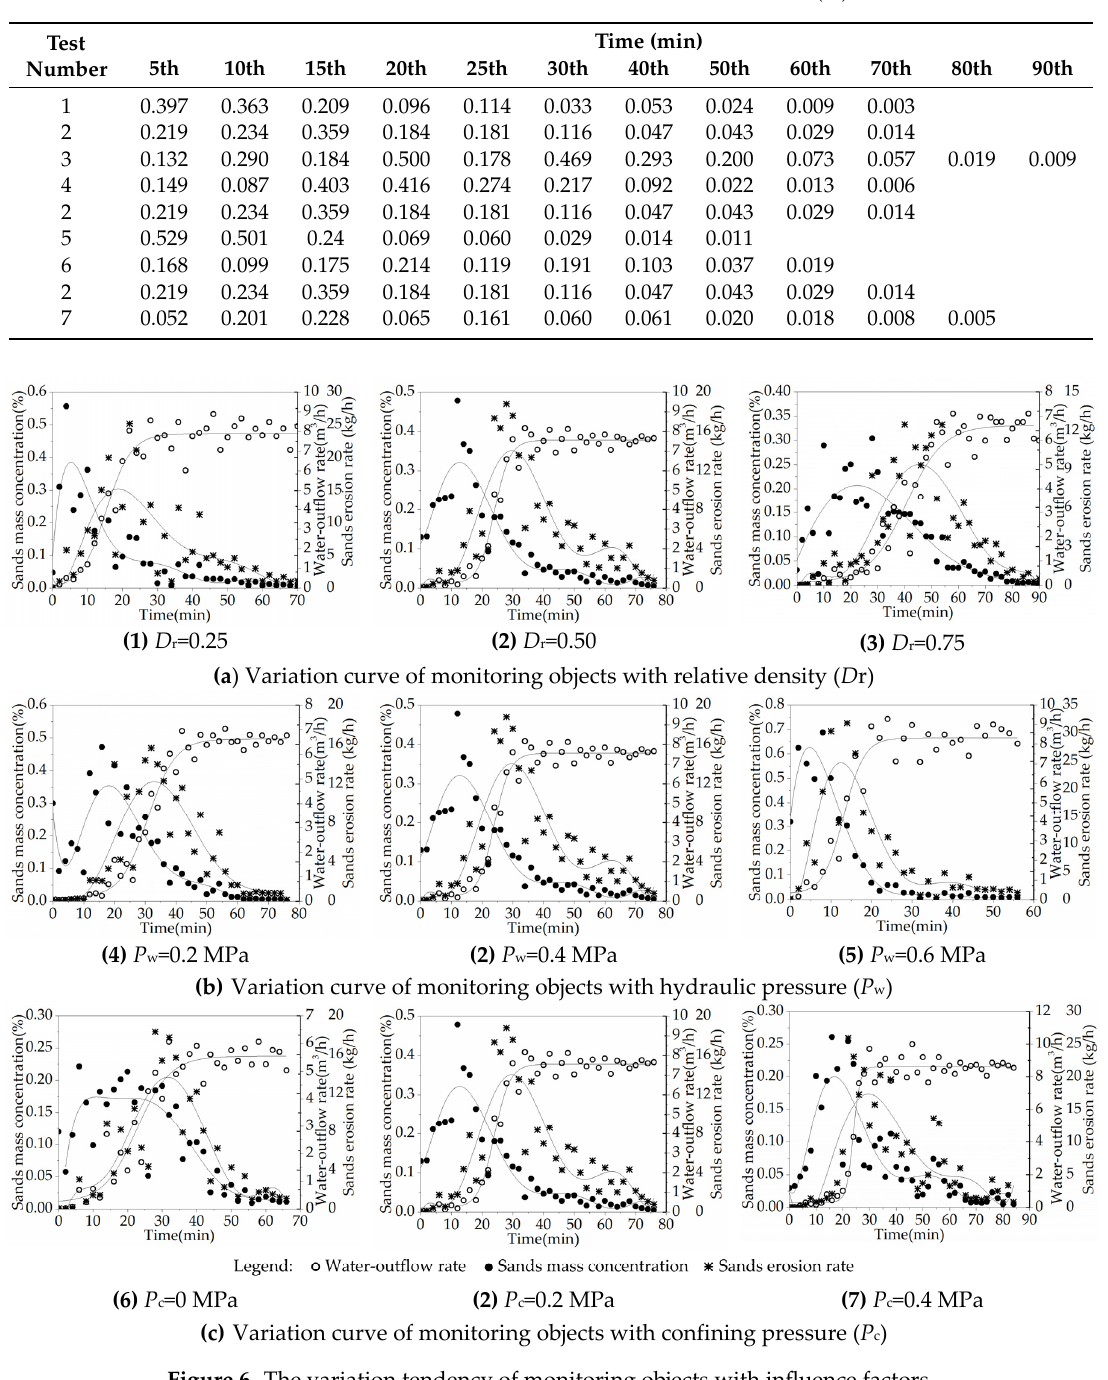
Table 5. Variation of sands mass concentration with time (%).